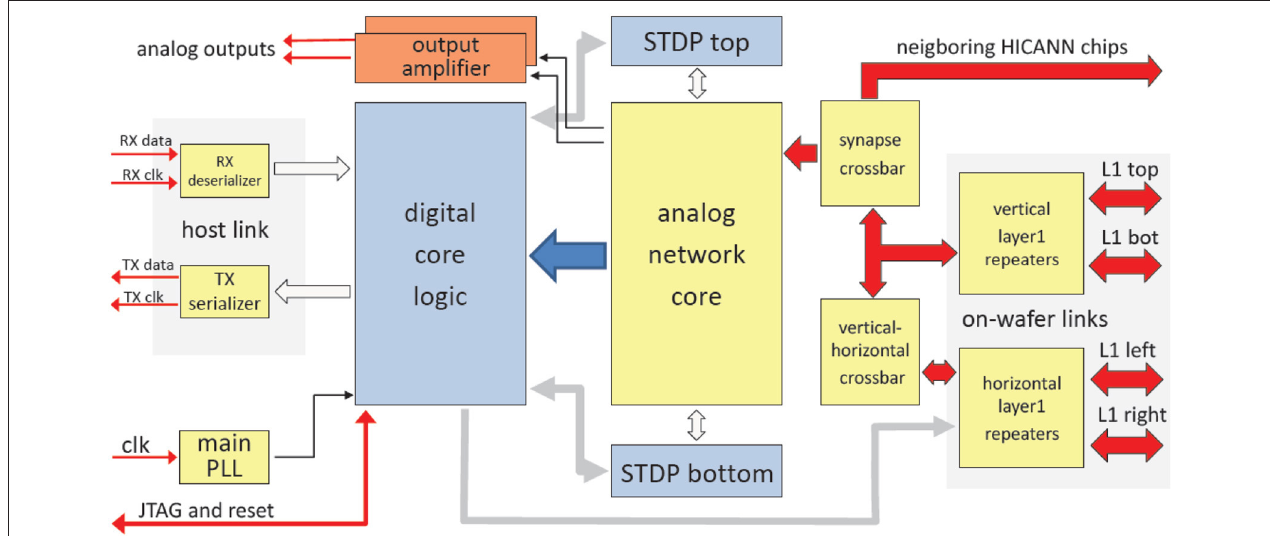
FIGURE 10 | Block diagram of the HICANN